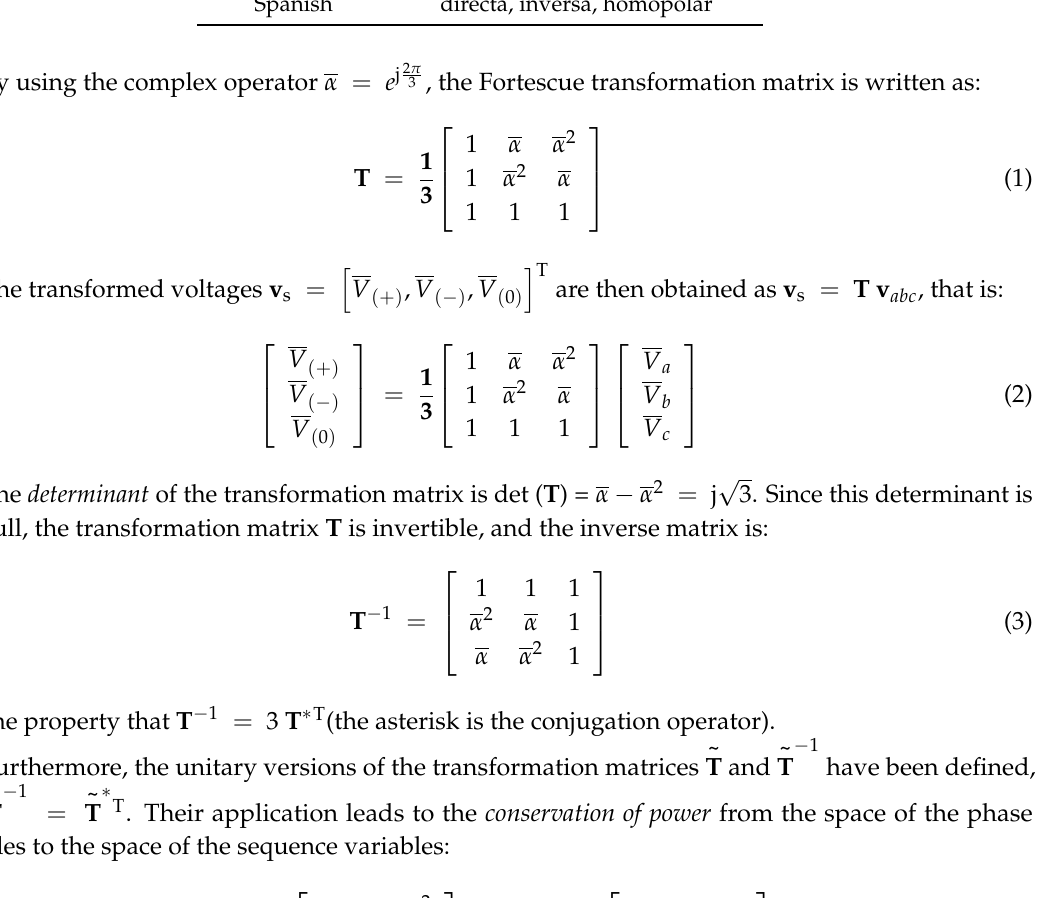
Table 1. Terminology used to represent the sequences in English and in the Latin languages. Language Terms Used for the Sequences English positive, negative, zero Italian diretta, inversa, omopolare French direct, indirect, homopolaire Portuguese directa, inversa, homopolar Romanian direct ă , invers ă , homopolar ă Spanish directa, inversa,